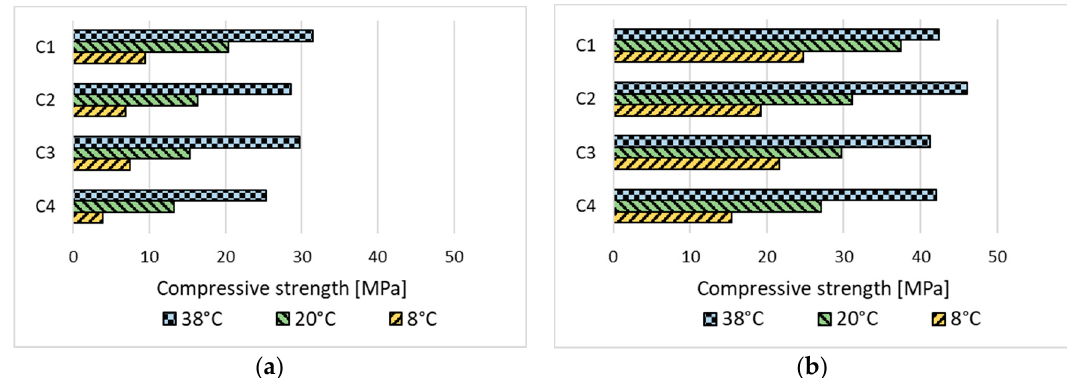
Figure 2. The influence of temperature on mortars compressive strength after: ( a ) two days of curing, ( b ) seven days of curing.